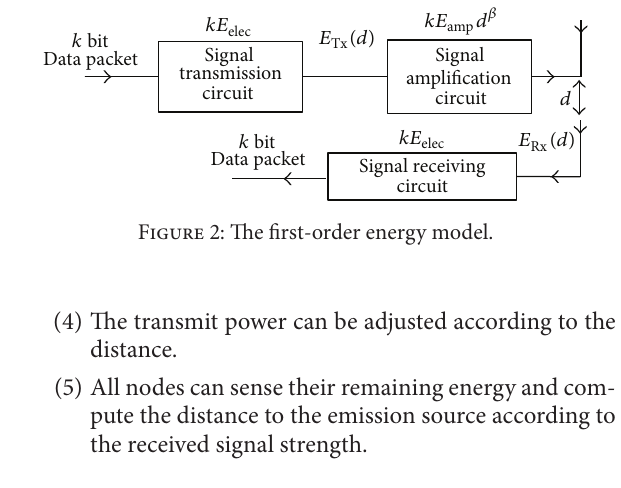
energy efficiency of nodes has been improved. But the balance of the energy consumption of network was not mentioned.